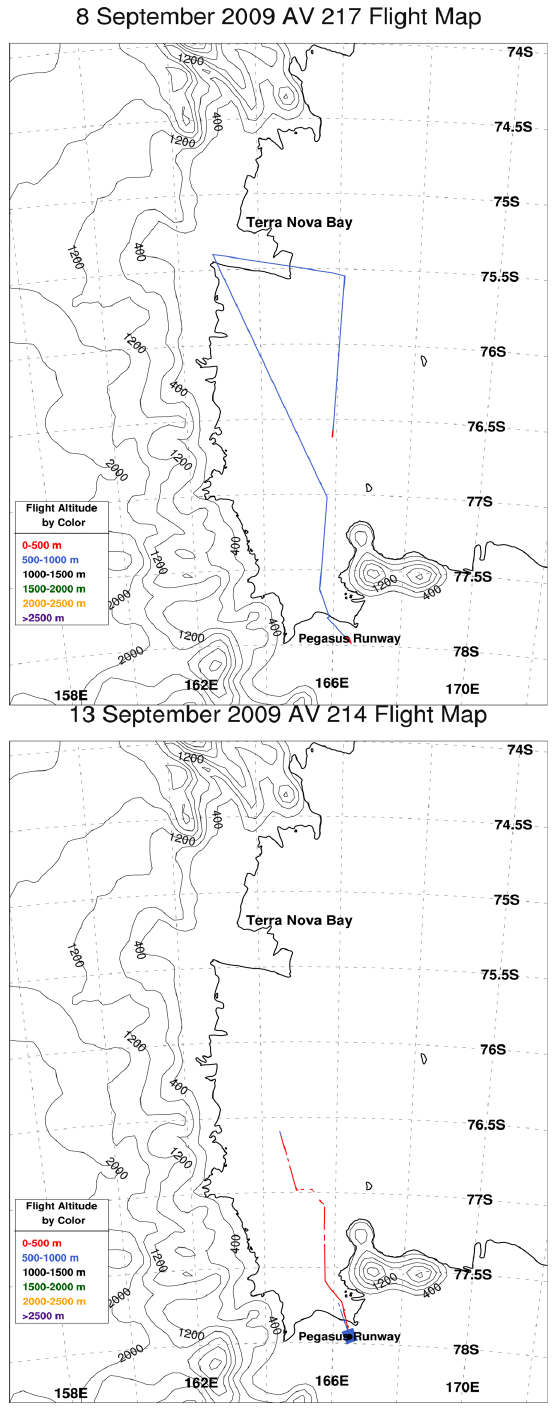
Figure 5. Flight paths for the two flights that did not reach Terra Nova Bay. Gaps in the flight path indicate a lack of data. Profile locations are marked with a black dot. Flight altitude is indicated by the color scale shown in each panel. Topographical contours are in